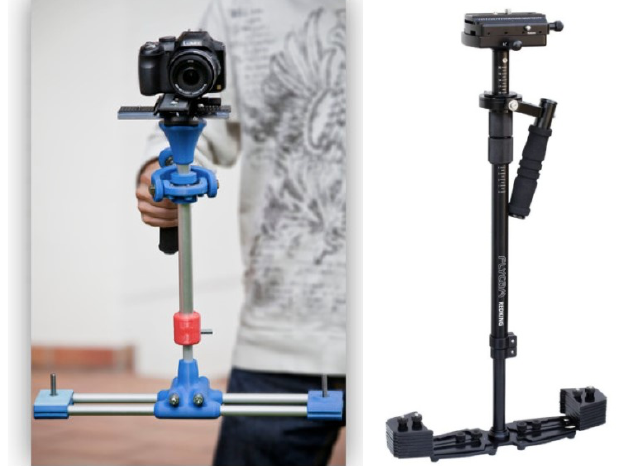
Figure 6: Comparison of open source version (left, camera is not included) and the commercial version (right) of the camera stabilizer (Sanladerer, 2021; Amazon,